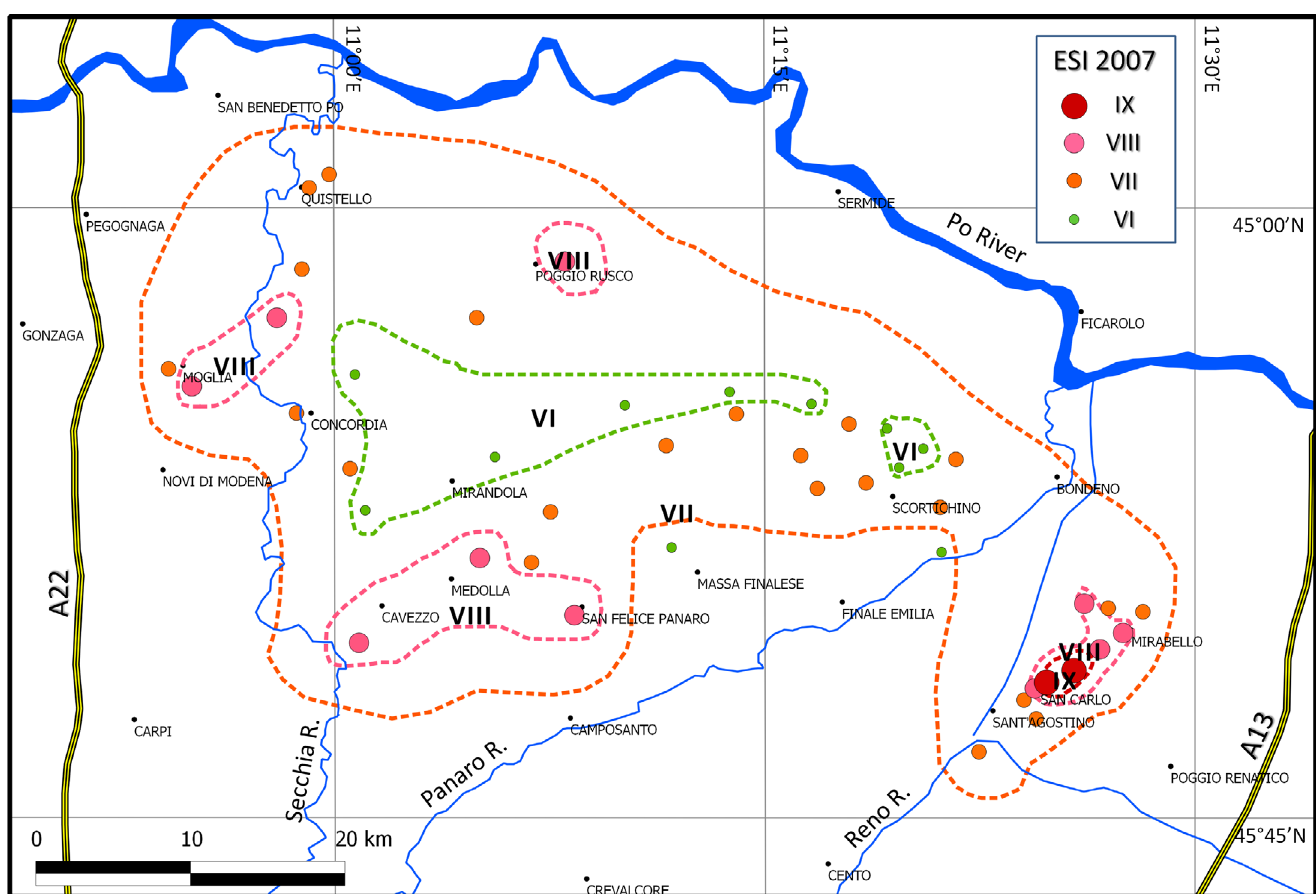
Figure 4. ESI local intensities (based on the characteristics of the surveyed ground effects) and inferred